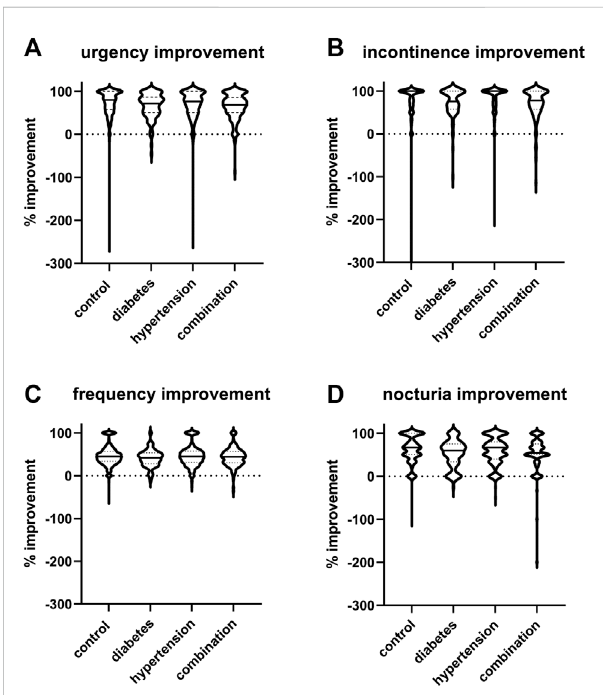
FIGURE 3 Violin plots of % changes in study I in number of (A) urgency, (B) incontinence, (C) frequency, and (D) nocturia episodes per 24 h. Median and interquartile ranges are indicated by the horizontal solid and dashed lines, respectively, within each plot. Note that only subjectwithapathologicalvalueatbaselinewereincludedaverysmall number of subjects exhibited a worsening, indicated here as negative value.